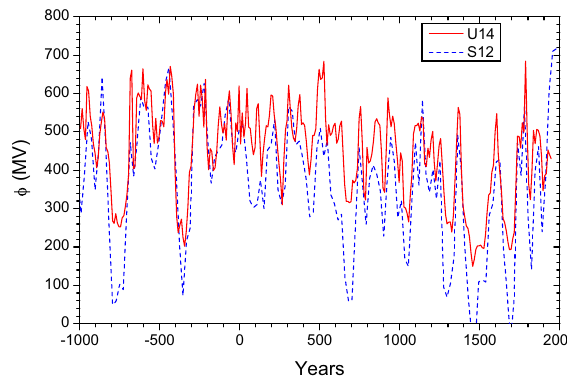
Fig. 16 Two reconstructions of the smoothed modulation potential φ for the last few decades: 22-year smoothed reconstruction (Steinhilber et al. 2012) based on a composition of 14 C and 10 Be data ( blue dotted curve ) and a 10-year averaged reconstruction (Usoskin et al. 2014) based on 14 C data ( red curve ). Error bars (roughly 50–100 MV for each curve) are not